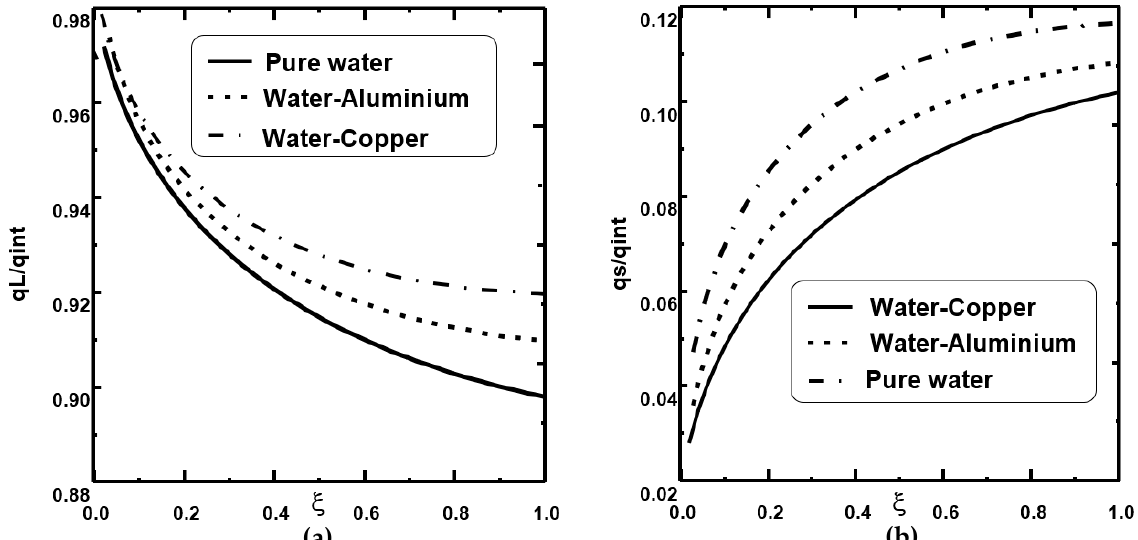
Figure 8. Effect of nanoparticles type on the latent ( a ) and sensible ( b ) heat fluxes: T 0 = 293.15 K, T 0L = 293.15 K, T w = 293.15 K, Φ 0 = 0.03, q 1 = − 1000 W/m 2 , c 0 = 0.3, u 0 = 1 m/s, m 0L = 0.015 kg/m.s, H = 1 m, d = 0.015 m, p 0 = 1 atm.